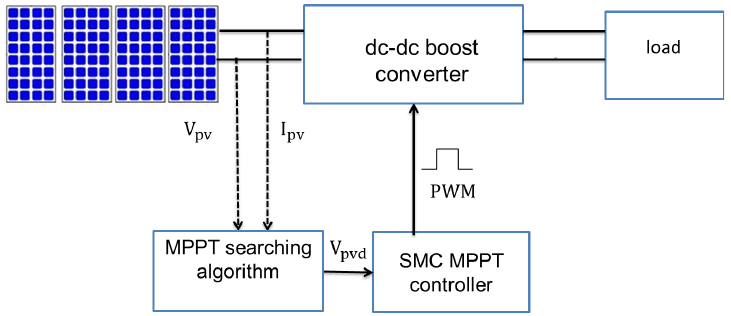
Figure 4. Controller